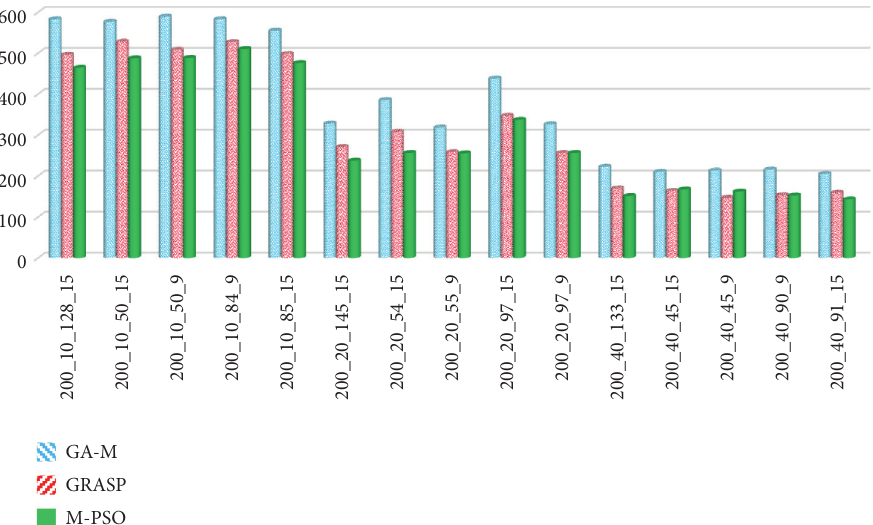
Figure 8: Comparing AVG values between GA-M, GRASP, and M-PSO of 200 tasks projects.